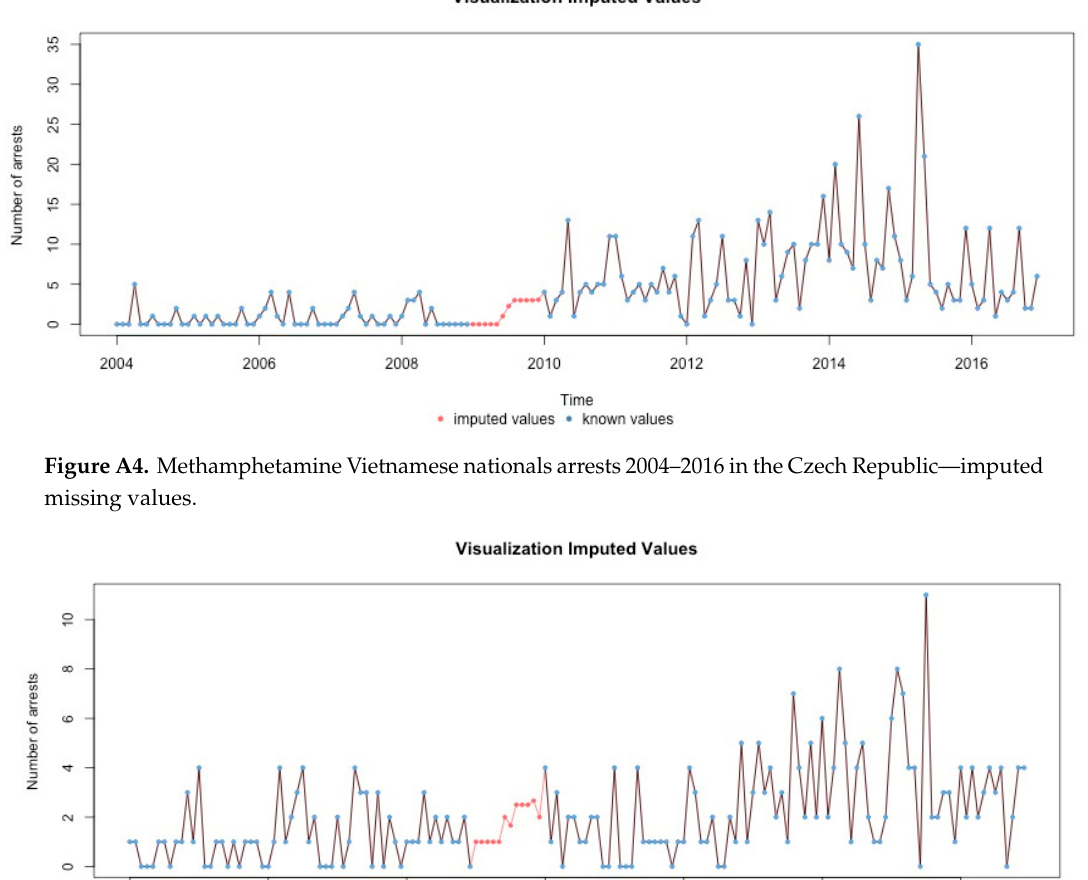
Figure A6. Precursor arrests 2004–2016 in the Czech Republic – imputed missing values.